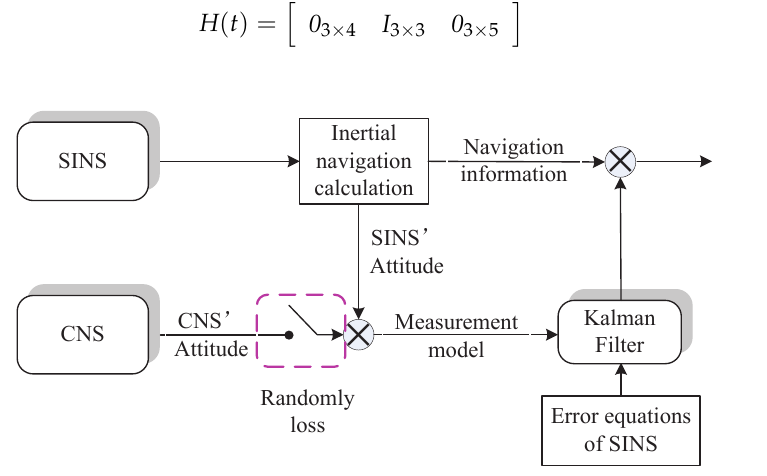
Figure 1. Schematic diagram of the SINS/CNS integrated system.